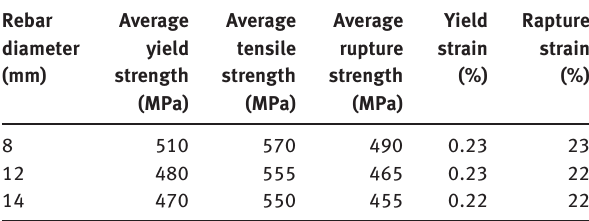
Table 4: Some mechanical properties of steel rebars used in the test